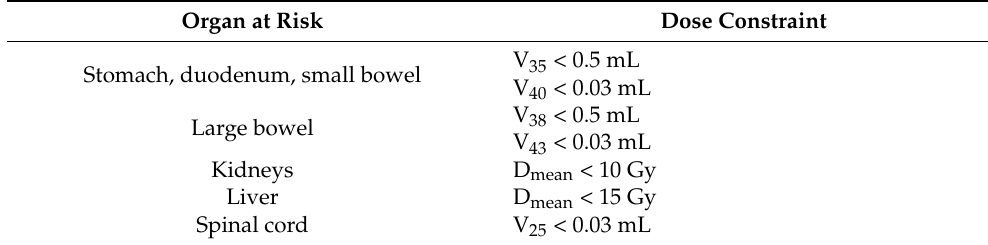
Table 1. Depicts organ at risk (OAR) dose constraints as used in the stereotactic MR-guided adaptive radiation therapy (SMART)